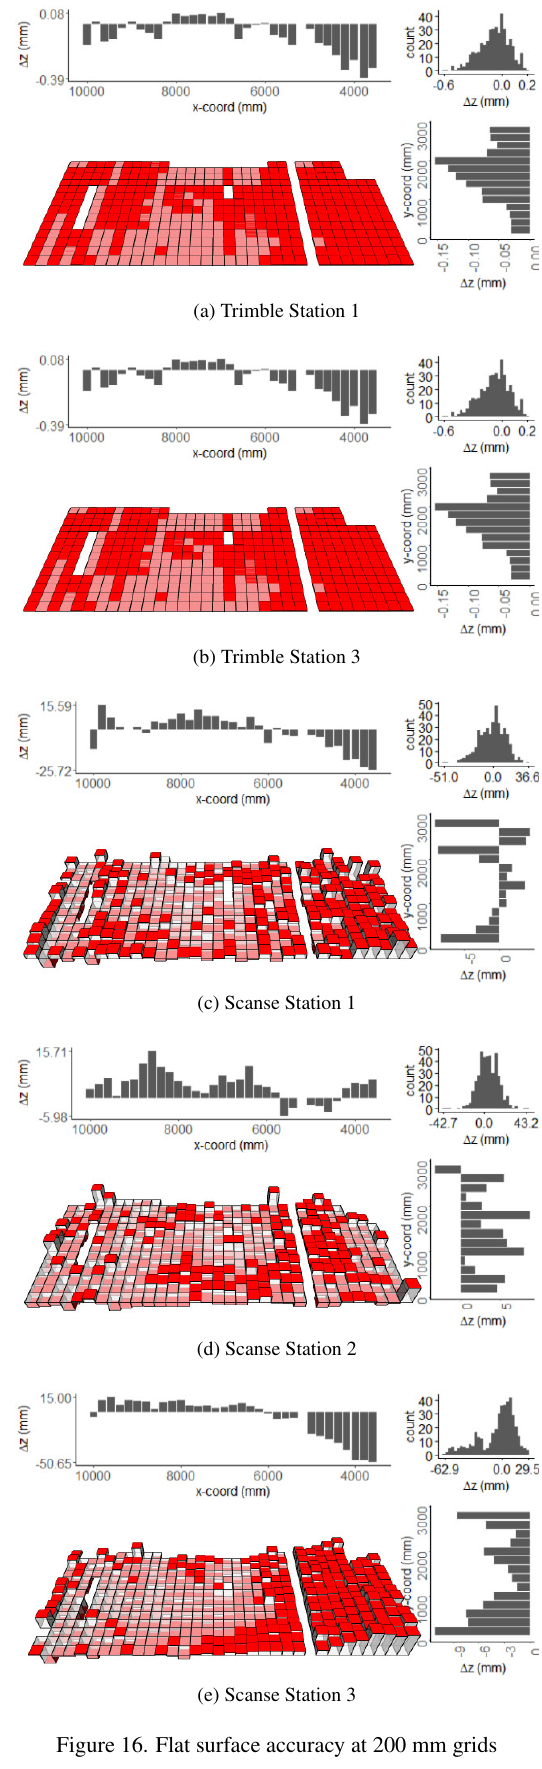
Figure 16. Flat surface accuracy at 200 mm